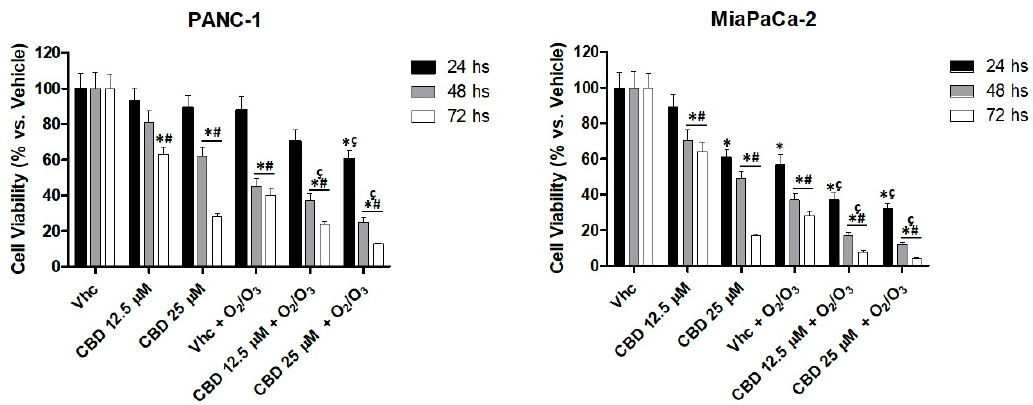
Figure 7. O 2 / O 3 improved CBD cytotoxicity in PDAC cell lines. Cell viability, up to 72 h, was determined by MTT assay. PANC-1 and MiaPaCa-2 cells were treated with O 2 / O 3 and CBD (12.5 and 25 µ M) in daily administration. Data shown are expressed as mean ± SE of three separate experiments. * p < 0.05 treated vs. vehicle, # p < 0.05 48, 72 h vs. 24 h, ç p < 0.05 vs.